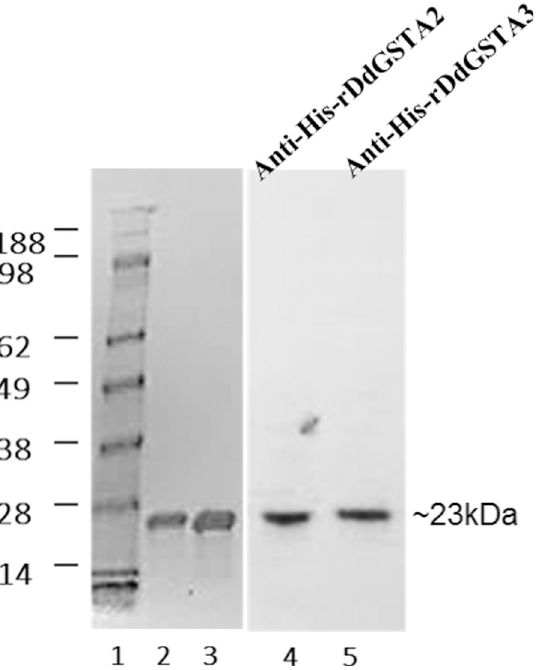
Fig 3. Expression and characterization of recombinant D . discoideum GST isozymes. Lane 1: Protein marker; Lanes 2–3: Coomassie staining of purified (6x His-tagged) rDdGSTA2 and rDdGSTA3 proteins; Lanes 4 and 5: Western blotting (anti-histidine monoclonal) of purified rDdGSTA2 and rDdGSTA3 enzymes, respectively.